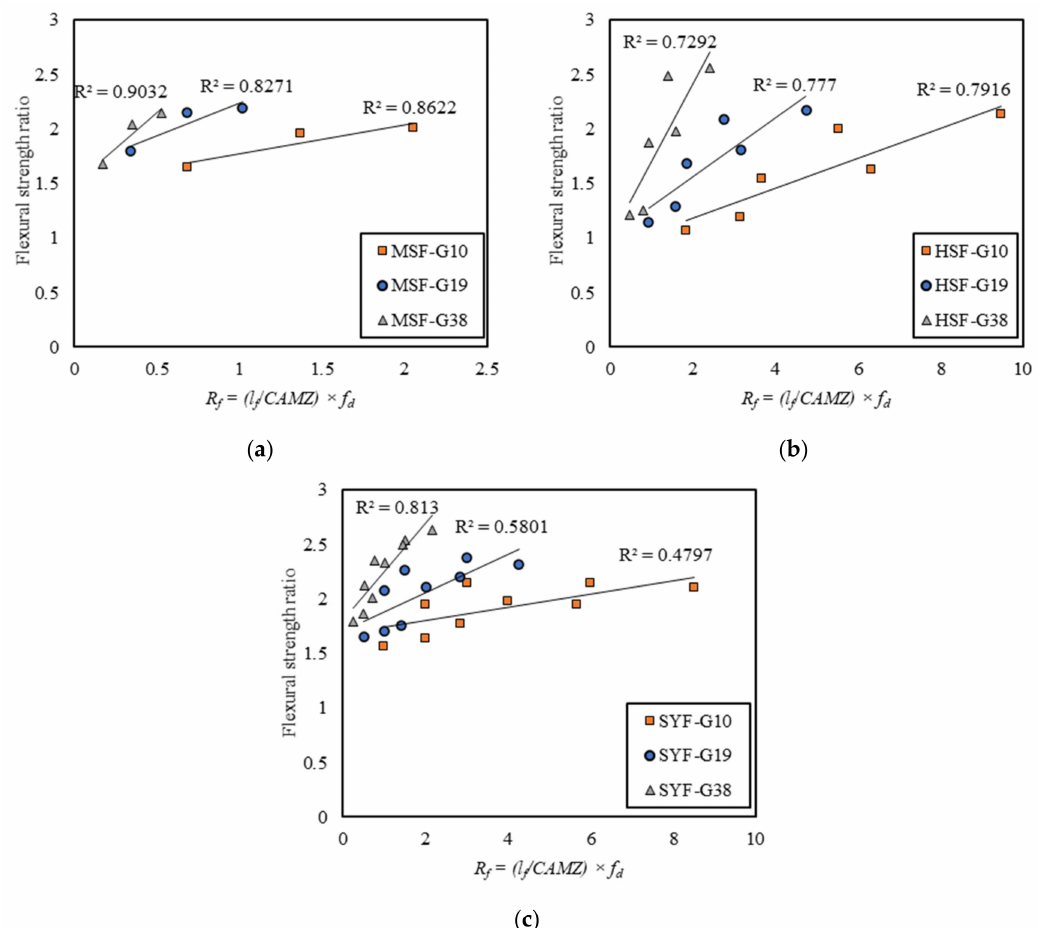
Figure 9. Effect of R f = (l f /CAMZ) × f d on the splitting tensile strength ratio of ( a ) micro steel fiber (MSF), ( b ) hooked end steel fiber (HSF), and ( c ) SYF